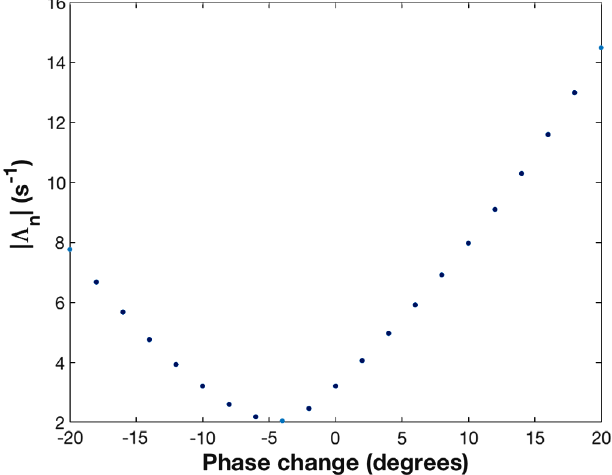
FIG. 16. Highest j Λ n j with llrf phase change. Configuration ( β ), OTFB Off.